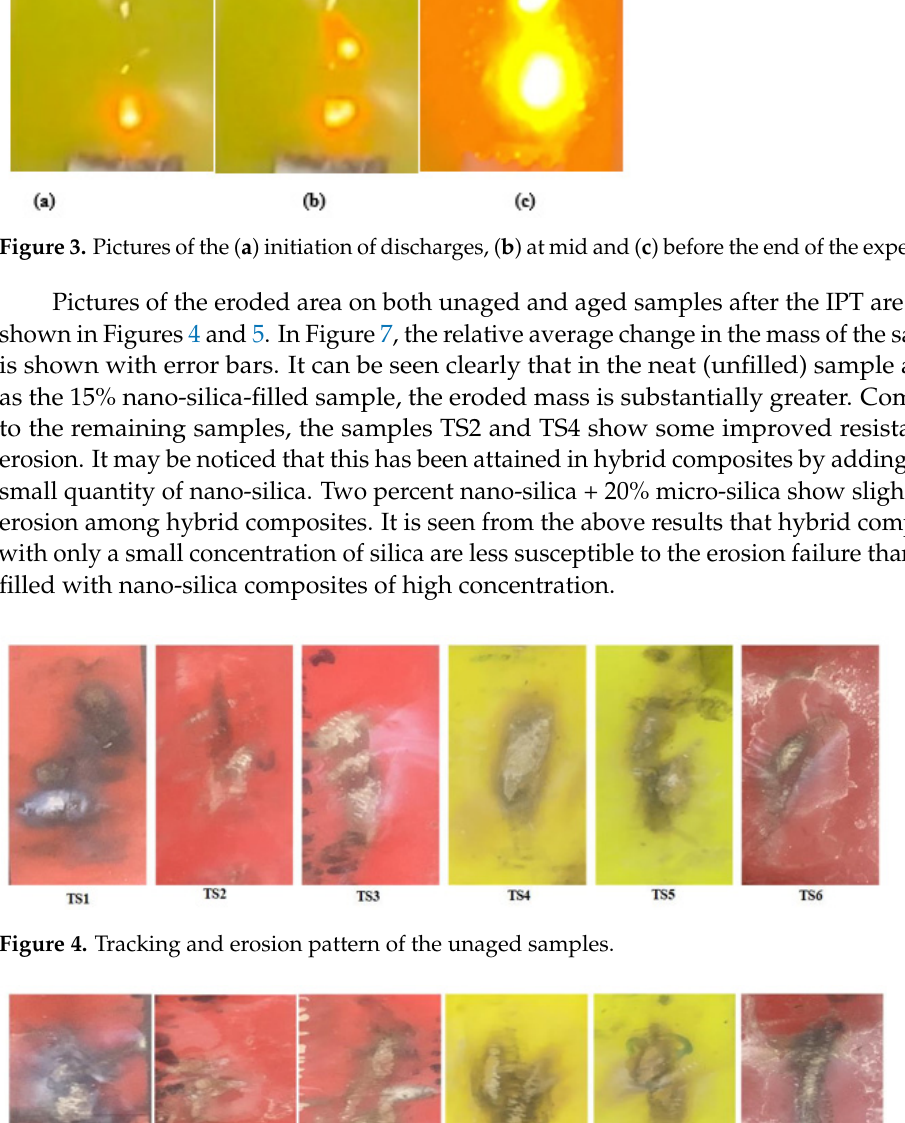
Figure 6. Tracking time of aged and virgin samples.